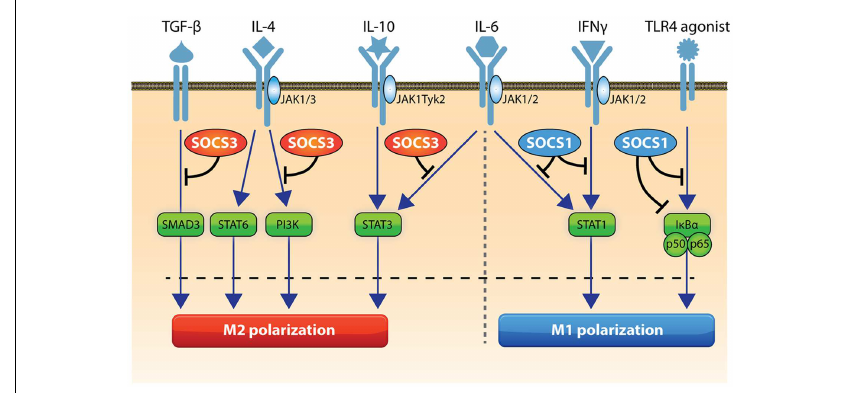
FIGURE 1 | Role of SOCS1 and SOCS3 in macrophage activation . STAT1 and NF κ B drive M1 polarization and SOCS1 can inhibit these pathways. SOCS3 can regulateTLR signaling and inhibits IL-6-induced STAT3 activation and SMAD3 and PI3K activity to action an appropriate destructive effect. STAT3, STAT6, and PI3K can drive M2 activation and SOCS3 inhibits STAT3 and PI3K. Pathways that trigger SOCS1 in macrophages include STAT1 and NF κ B, while SOCS3 expression can be induced by STAT3, NF κ B, NOTCH1, PI3K, and MAP kinase